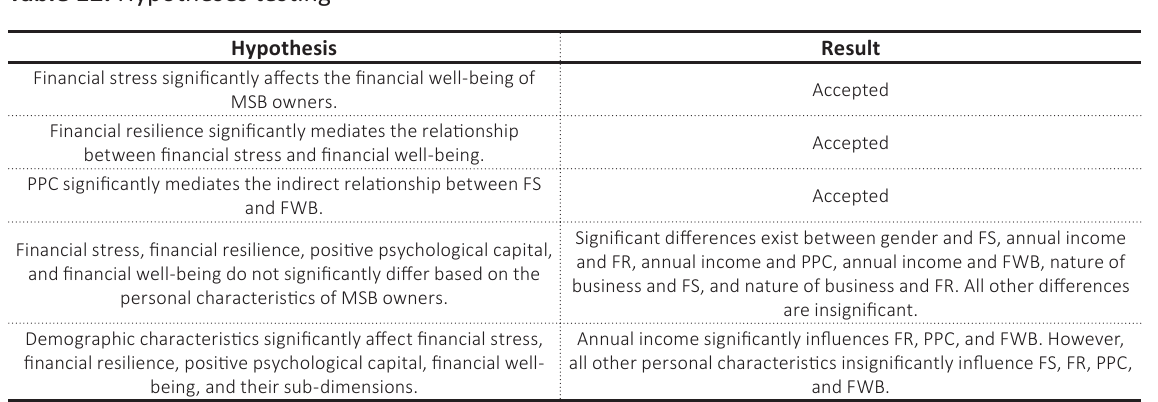
Table 12. Hypotheses